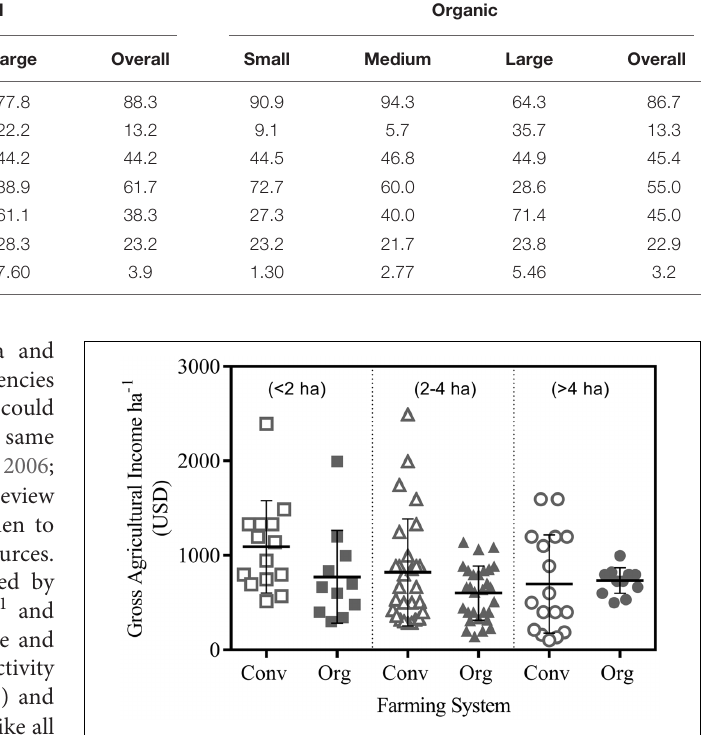
FIGURE 1 | Gross agricultural income ha − 1 of organic (Org) and conventional (Conv) farmers (1 USD = 62 INR).